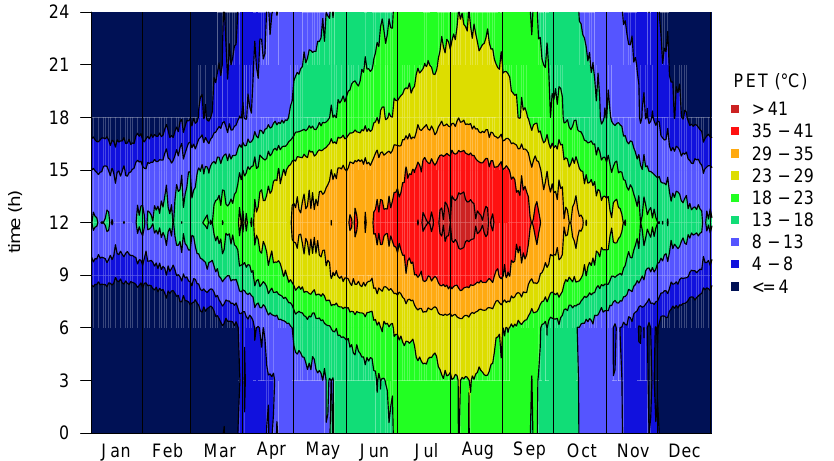
Figure 5. Temporal diagram for PET for Tokyo with a temporal resolution of three hours over the period from October 1966 to July 2018. The x -axis represents the months during a year and the y -axis the variation throughout the day. The thermal sensation classification is stated in Table